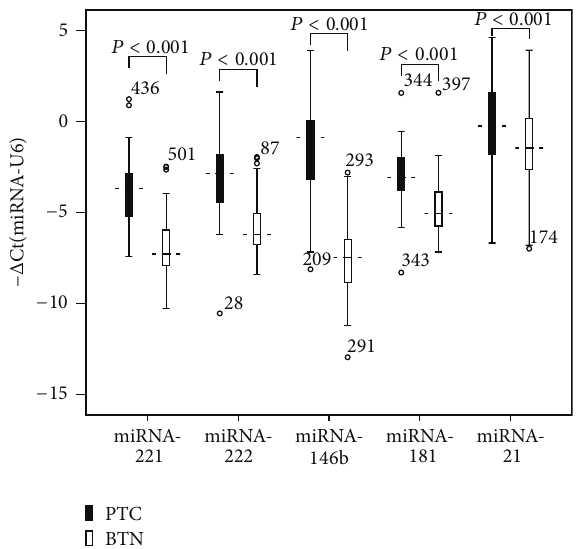
Figure 1: Box plotsof miRNAexpression levels of patients with PTC ( 𝑛 = 52 ) and BTN ( 𝑛 = 52 ). The levels of miRNA-221, miRNA-222, miRNA-146b, miRNA-181, and miRNA-21 were significantly higher in PTC patients than in BTN patients ( 𝑃 < 0.05 for all comparisons). All indicated 𝑃 values were determined by the Mann-Whitney 𝑈